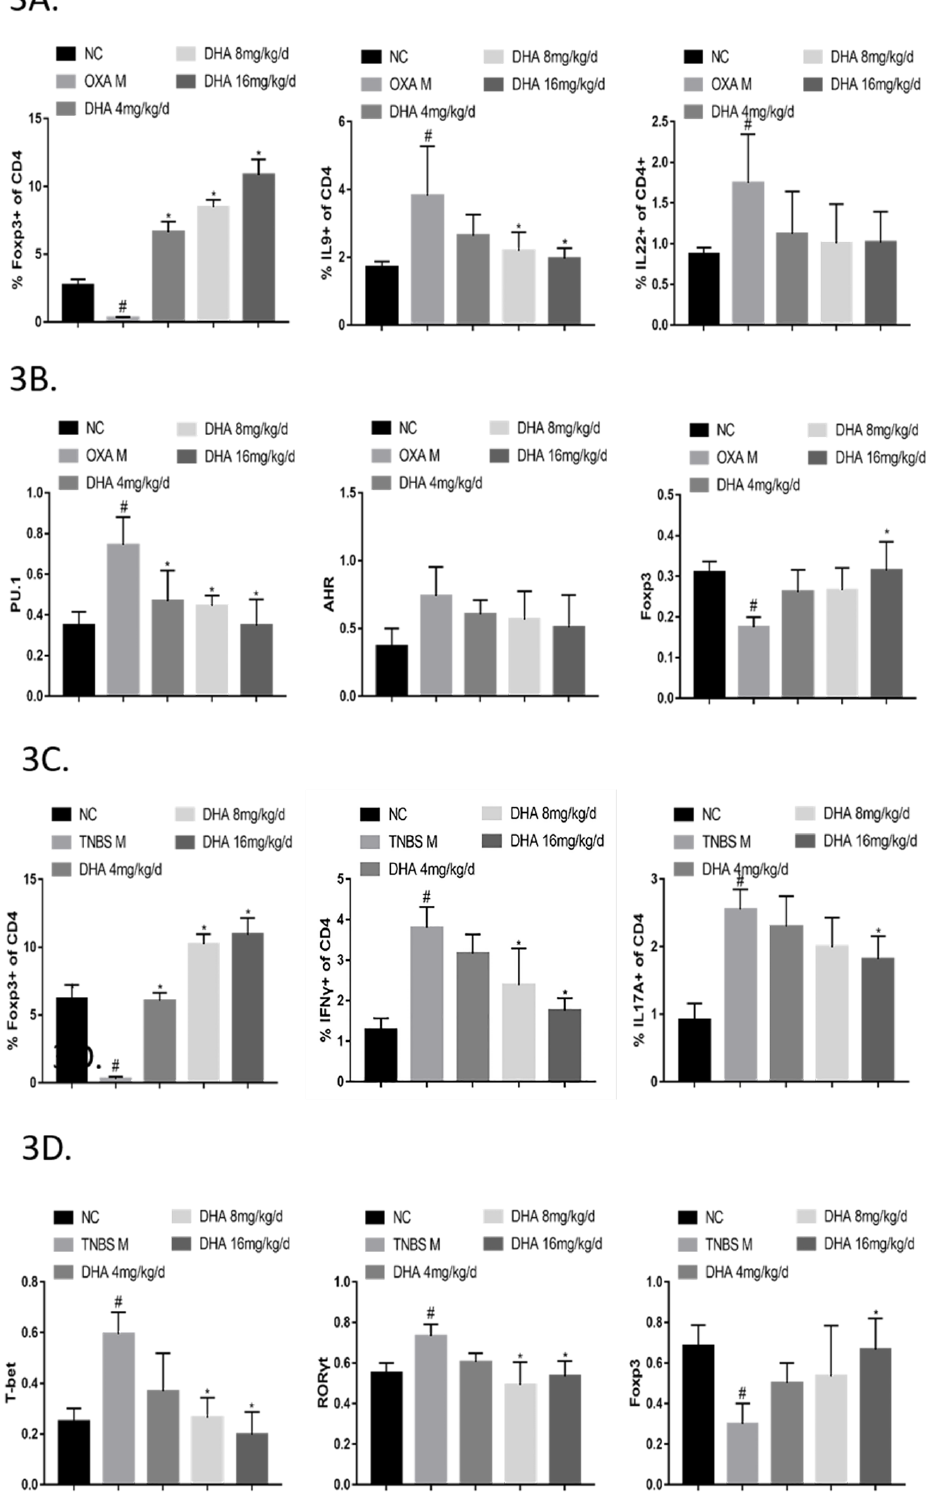
Figure 3. Dihydroartemisinin (DHA) regulates the Th / Treg balance in oxazolone (OXA)- and 2,4,6-trinitro-benzene sulfonic acid (TNBS)-induced colitis. ( 3A ) Lymphocytes were isolated from mouse spleens. CD4 + IL (Interleukin) 9 + , CD4 + IL22 + and CD4 + CD25 + Foxp3 + cells were determined by flow cytometry. ( n = 5). ( 3B ) Lamina propria mononuclear cells (LPMCs) were isolated and